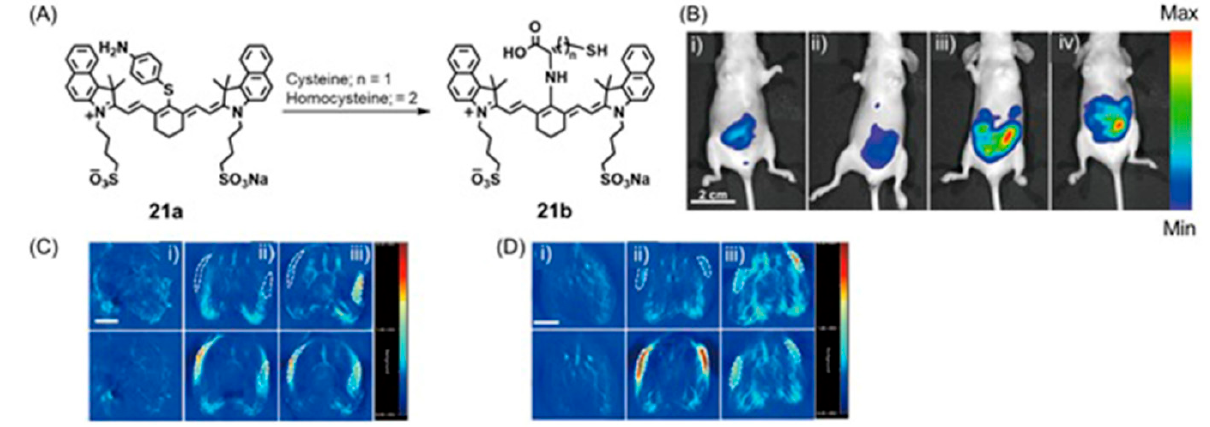
Figure 44. ( A ) Conversion of 21a to 21b in the presence of cysteine and homocysteine. ( B ) Fluorescence images of mice after intraperitoneal injection with 21a . (I) images were collected 20 min after injection (50 µ M, 100 µ L of 21a ). (II) mice were injected with N -ethylmaleimide (a canonical biothiols scavenger) for 30 min, then 21a (50 µ M, 100 µ L) was injected and imaging performed after 20 min. (III) and (IV) mice were pre-injected with 1 mM N -ethylmaleimide and then injected intraperitoneally with (III) cysteine (1 mM, 50 µ L) or (IV) homocysteine (1 mM, 50 µ L), and then 21a (50 µ M, 100 µ L) was injected and imaging occurred after 20 min. Excitation wavelength = 660 nm; Emission wavelength = 780 nm. ( C , D ) Representative in vivo photoacoustic images of mice subcutaneously injected with 21a . Signals were collected under two laser light sources 695 [top panels of both ( C , D )] and 840 nm [bottom panels of both ( C , D )]. (VI) before injection with 21a (50 µ M, 100 µ L); (VII) injection with 21a ; (VIII) injection with saline (100 µ L, left leg) and cysteine (100 µ L, 1 mM, right leg); (IX) before injection with 21a (50 µ M, 100 µ L); (X) injection with 21a ; (XI) injection with saline (100 µ L, left leg) and homocysteine (100 µ L, 1 mM, right leg). Scale bar = 5 mm. Adapted by permission